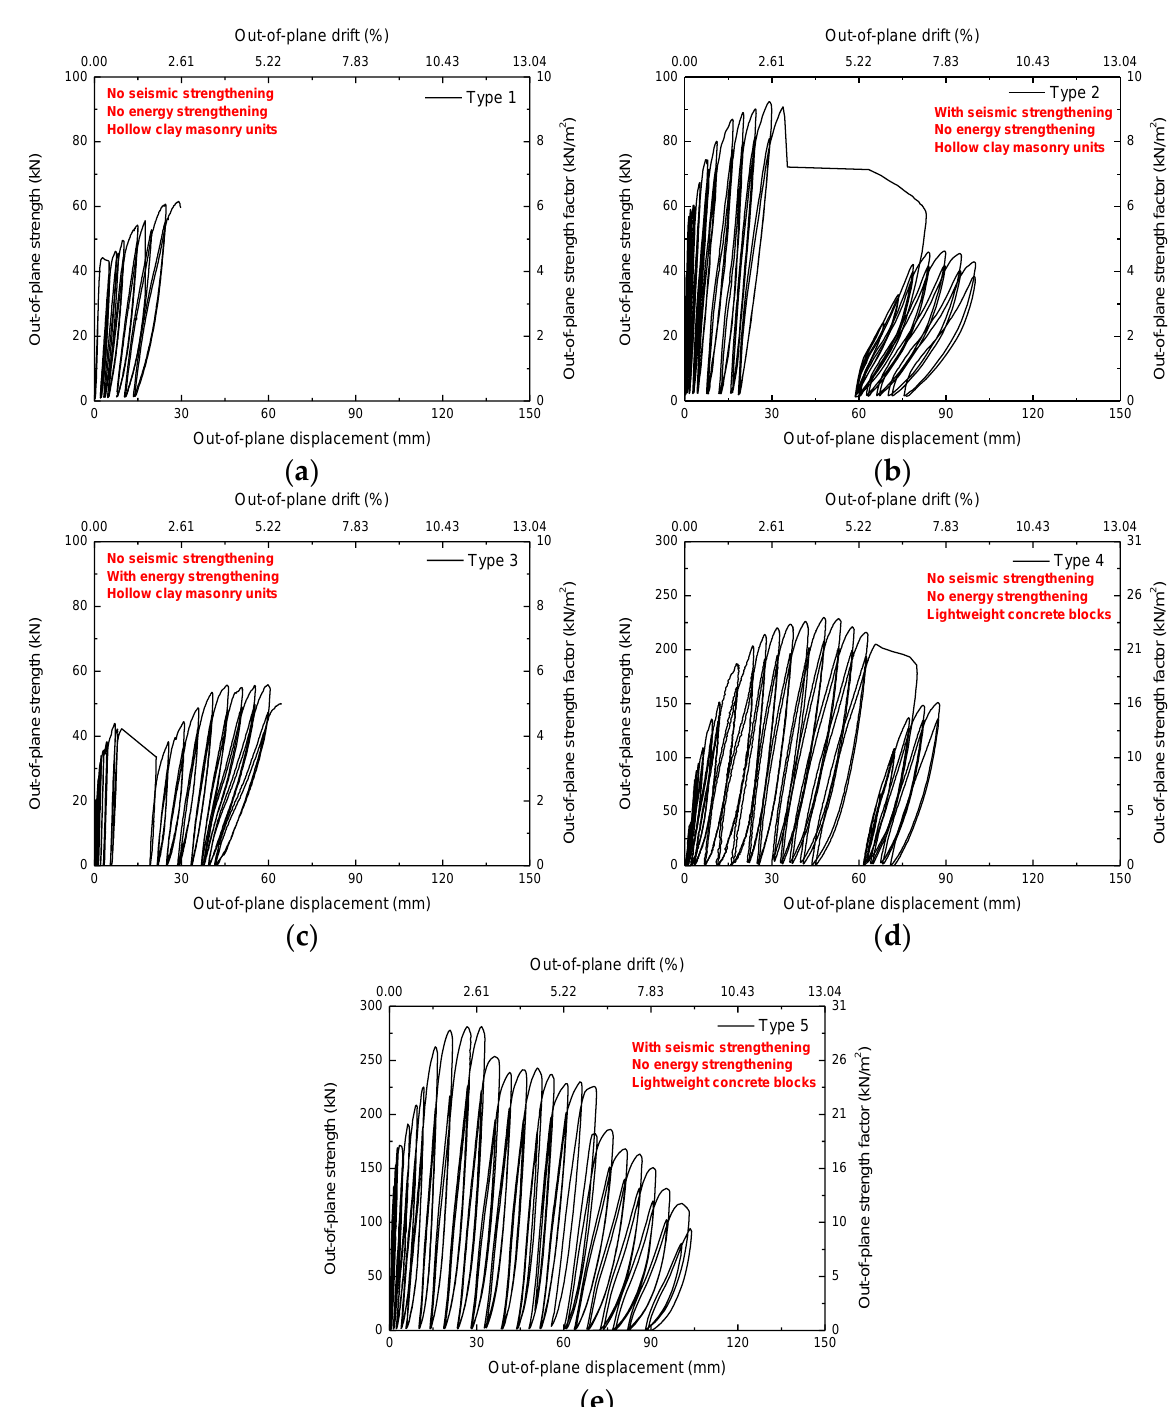
Figure 8. Structural performance assessment (force–displacement curves) ( a ) wall type 1; ( b ) wall type 2; ( c ) wall type 3; ( d ) wall type 4; ( e ) wall type 5.